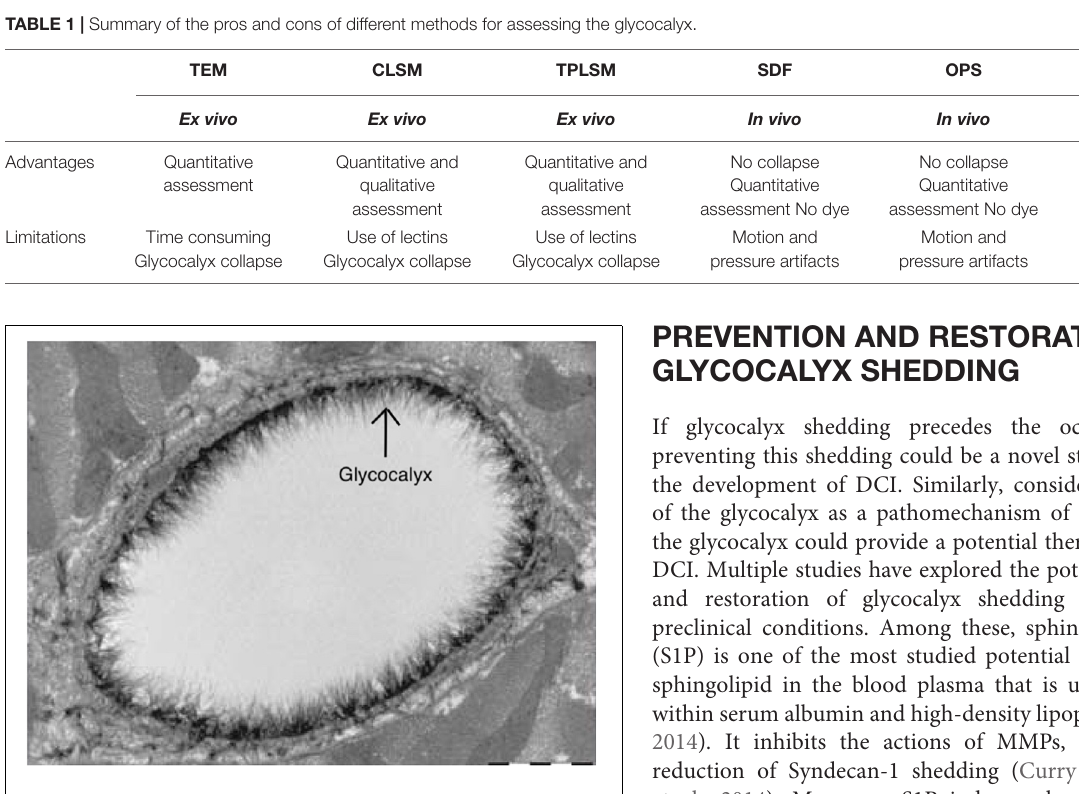
FIGURE 4 | Electron microscopy image of the endothelial glycocalyx from Reitsma et al. (2007), with permission. Endothelial glycocalyx ( arrow) of a rat left ventricular myocardial capillary following staining with Alcian blue 8GX. Image is created using